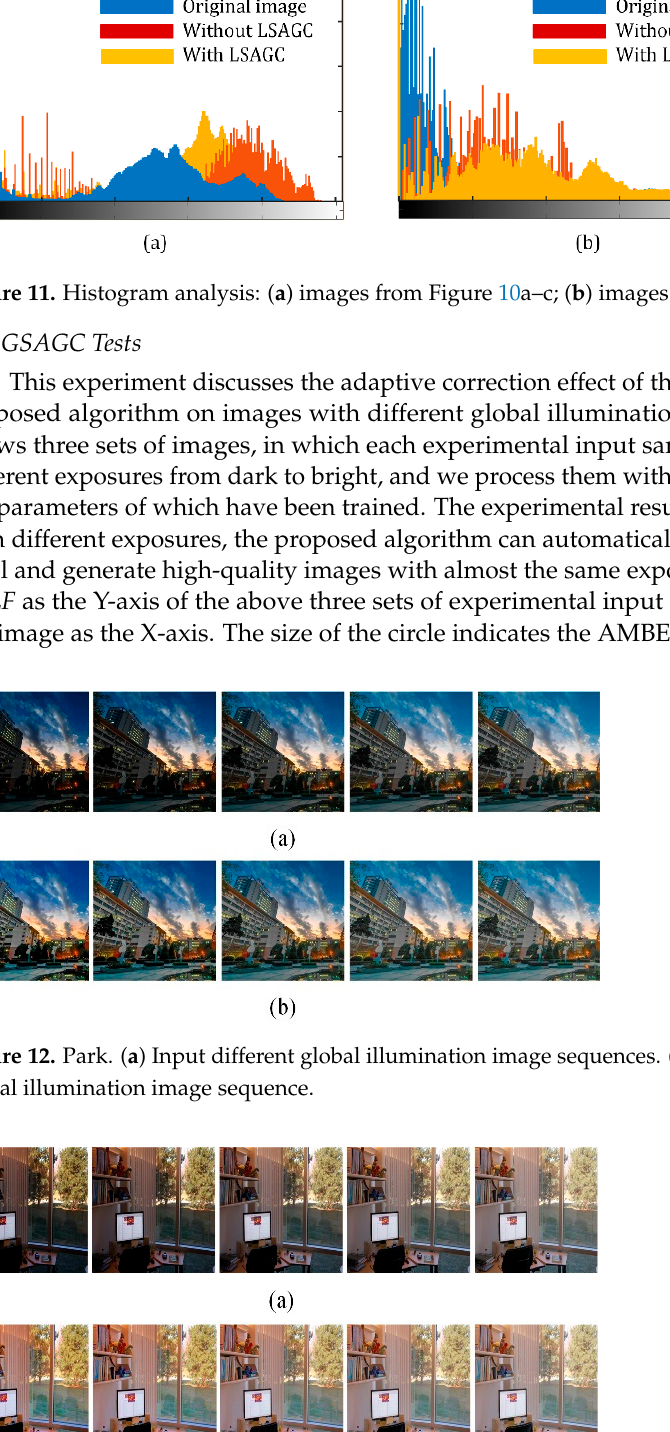
Figure 10. Effect of LSAGC. ( a , d ) Original images. ( b , e ) Enhanced images without LSAGC. ( c , f ) Enhanced images with LSAGC.